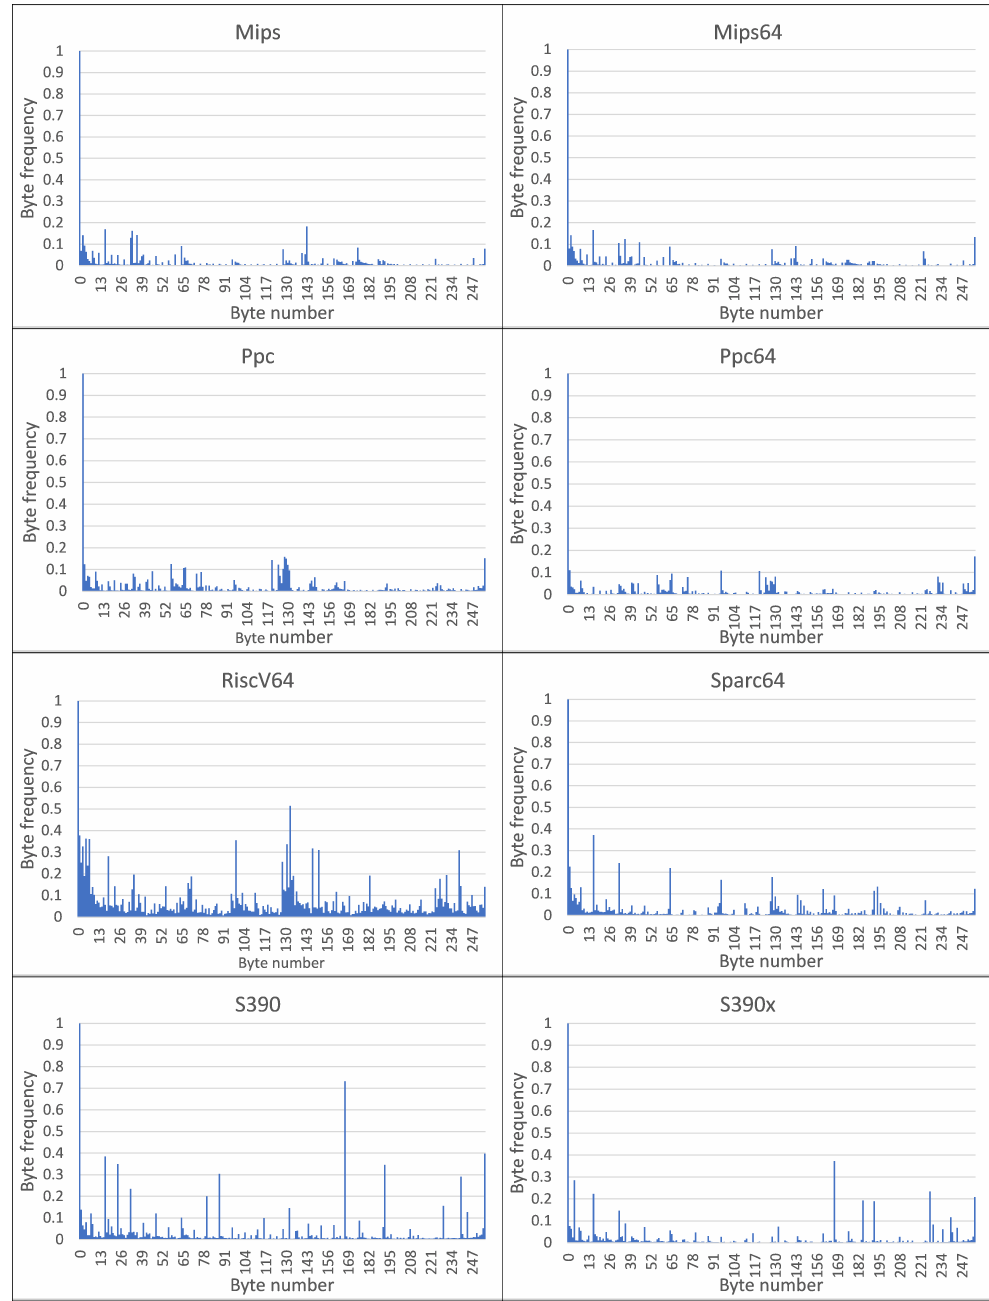
Figure 3. Byte-frequency signatures of MC classes for Top-16 CPDoSH Architectures (for Mips, Mips64, Ppc, Ppc64, RiscV64, S390, S390x and